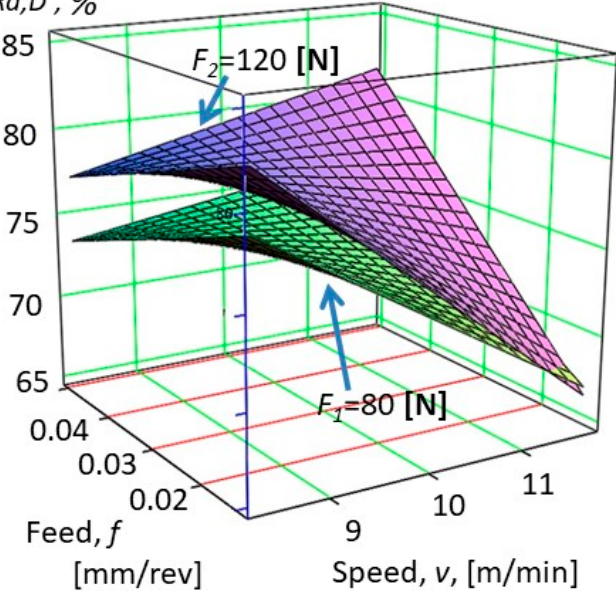
Figure 8. Improvement of the change of surface roughness ρ Ra , D on specimens marked D (see Equation (6)).